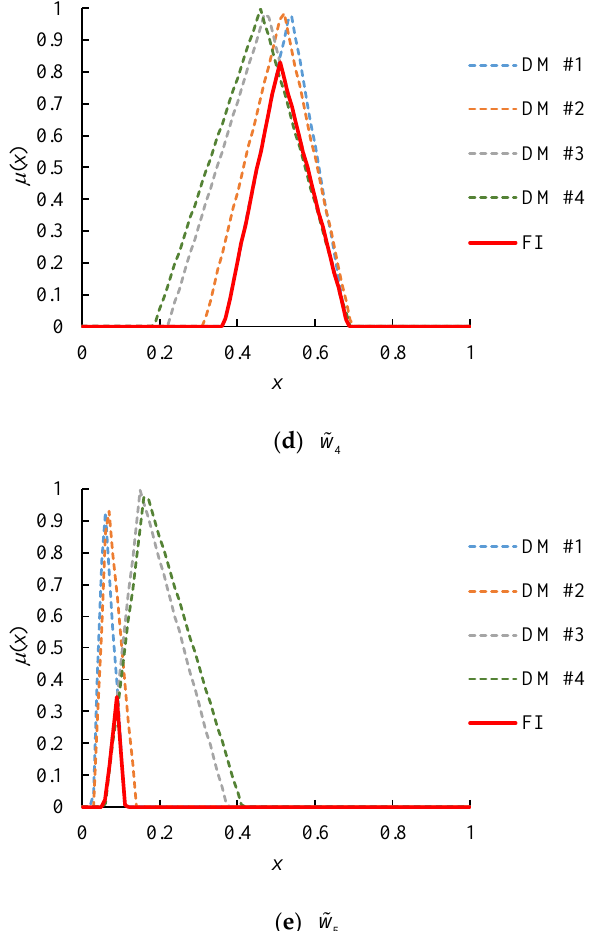
Figure 8. The fuzzy intersection (FI) results of the relative priorities.